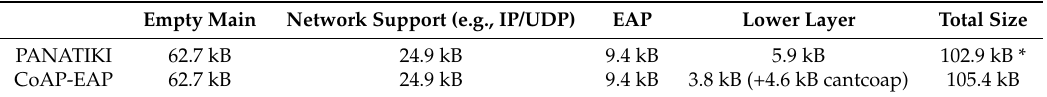
Table 3. Implementations memory